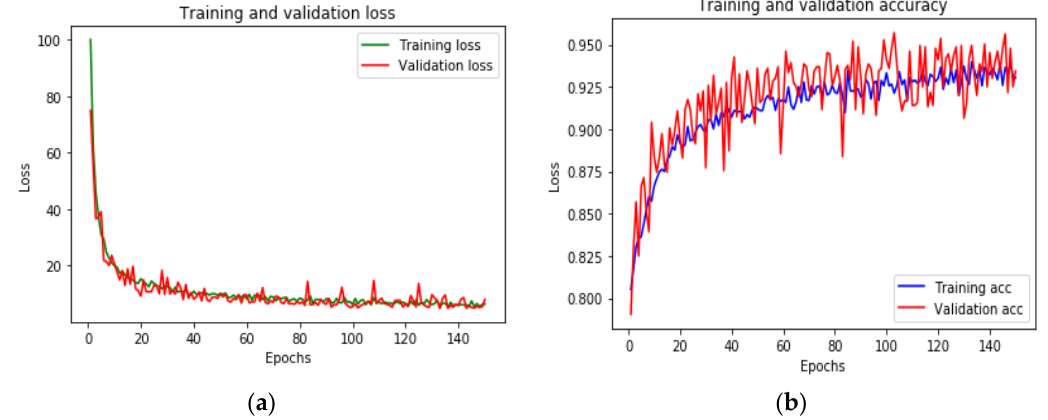
Figure 11. Training and validation ( a ) loss and ( b ) accuracy for the deep MLP model.